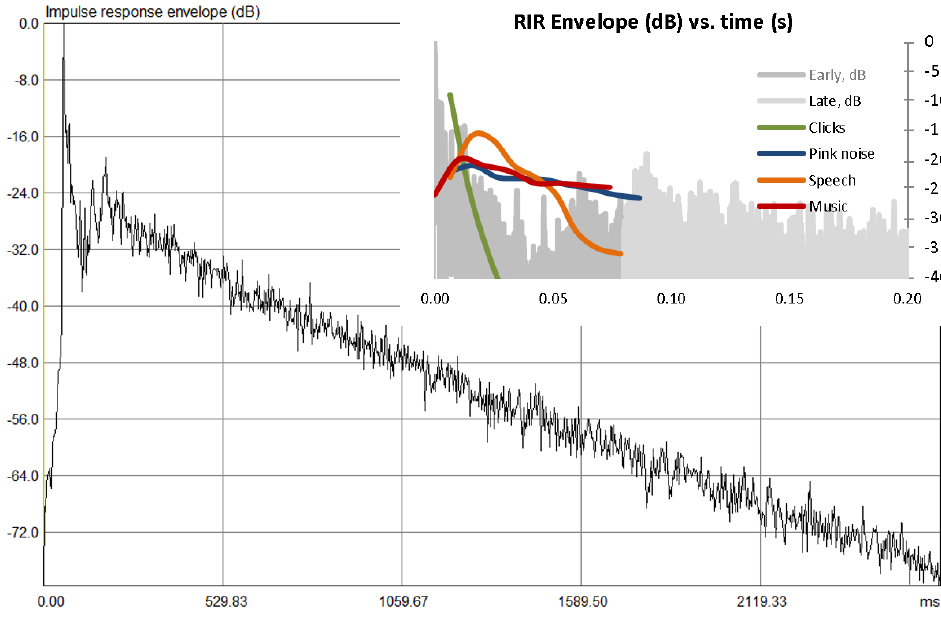
Figure 8. Impulse response envelope. The source in B and microphone in P2.